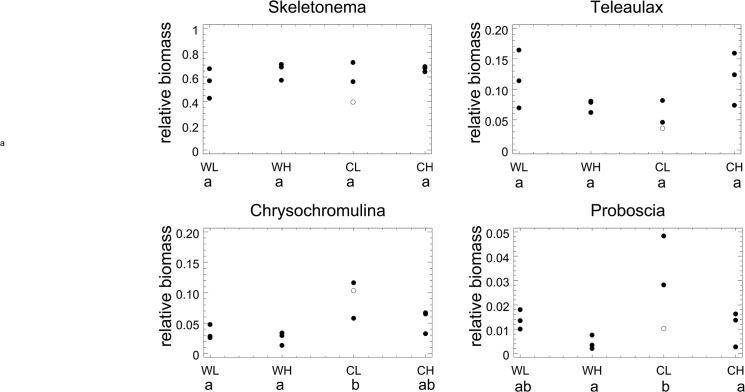
Relative biomass of selected species.Relative biomass (mean over entire duration of experiment) of the two most abundant species (Skeletonema marinoi, Teleaulax acuta) and of the most abundant species responsive to temperature (Chrysochromulina sp.) and the most abundant species responsive to CO2-enrichment (Proboscia alata). Treatment codes: WL: warm, low CO2, WH: warm, high CO2, CL: cold, low CO2, CH: cold, high CO2; codes for homogenous groups according to Tukey’s HSD: a, b.